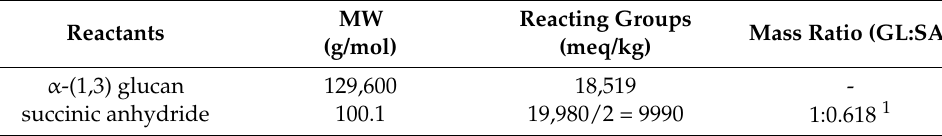
Table 1. Equimolar calculations for modification of α -(1,3) glucan with succinic anhydride. MW Reactants (g/mol)